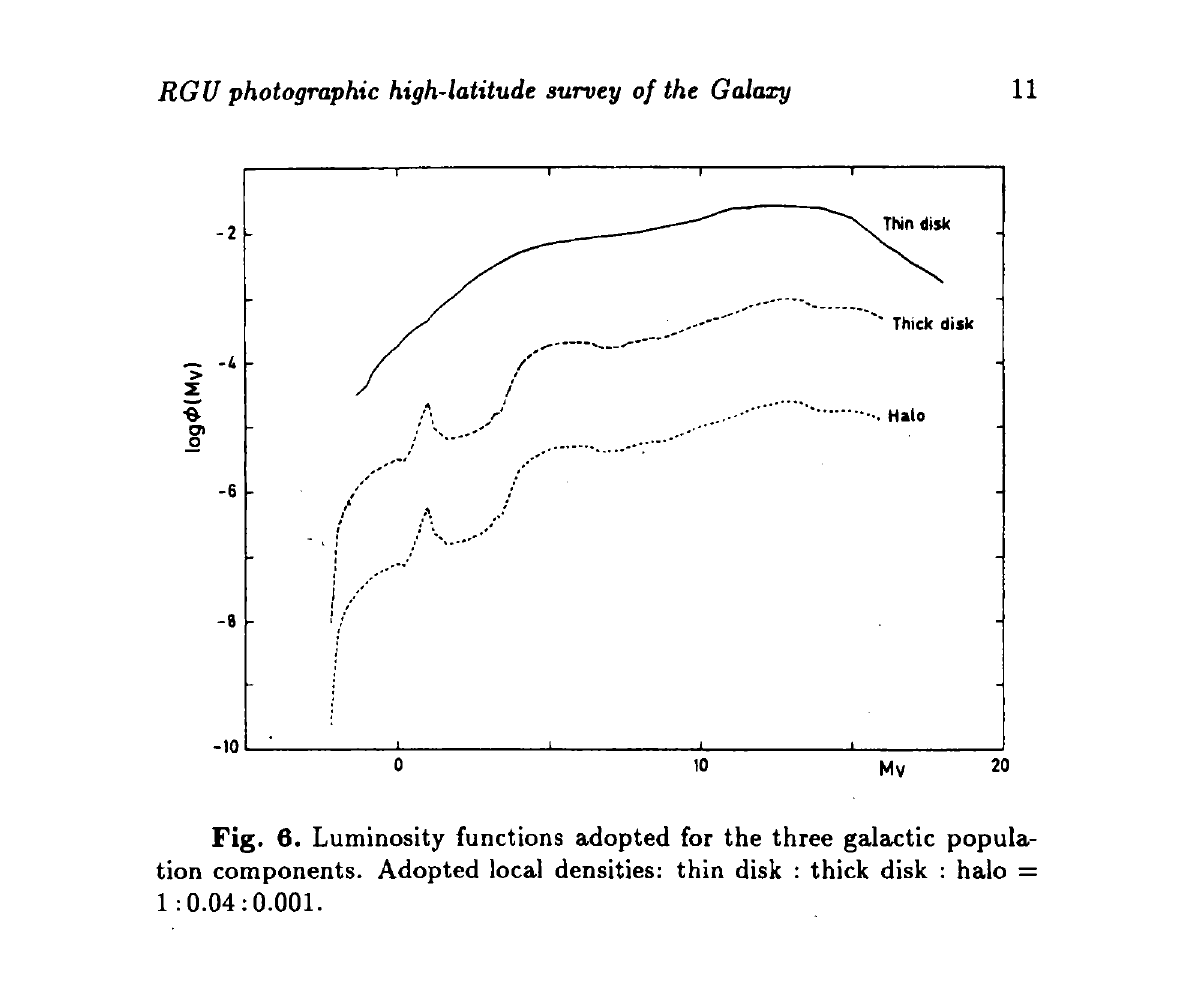
Table 3. Parameter values for the galactic